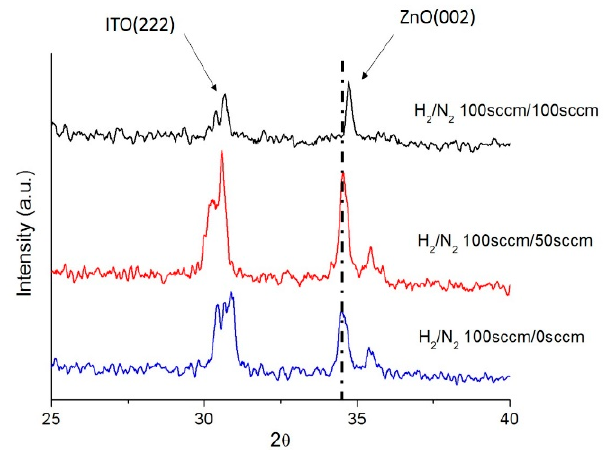
Figure 2. XRD patterns of the H 2 / N 2 plasma processed AZO / ITO films.